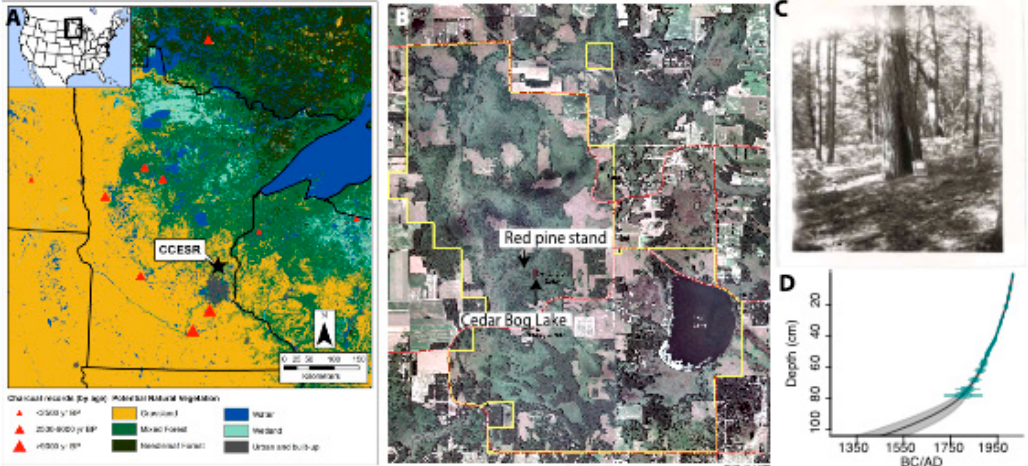
Figure 1. ( A ) Location of sedimentary charcoal records in the upper Midwestern U.S. No sites are in the savanna biome and none have examined mixed fuel sources characteristic of savanna fire regimes. Source: Global Charcoal Database. ( B ) Aerial photography of Cedar Creek Ecosystem Reserve, with the red pine area and Cedar Bog Lake indicated. Red dashed lines are public rods and yellow line is CCESR boundary. ( C ) Photograph from 1954 of the red pine stand [31]; the tree in the foreground was living at the time of our sampling and cored, while the fire-scarred tree to the right and in the background was dead and sampled with a chainsaw. ( D ) Age-depth model for the Cedar Bog Lake short core based on 210 Pb and 14 C dates (not shown).